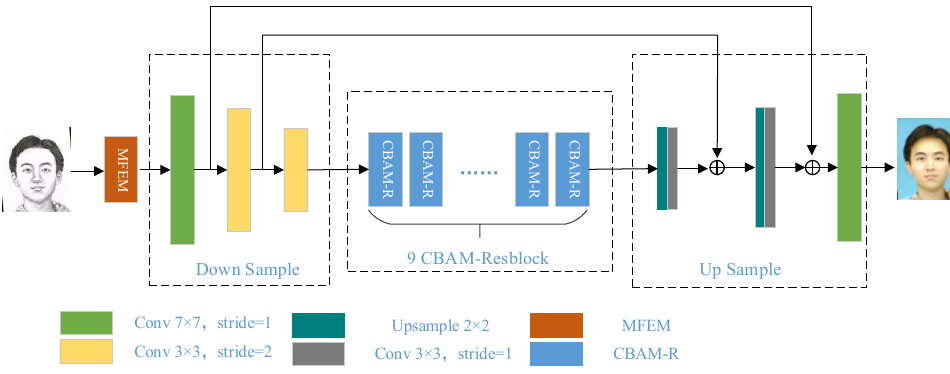
Figure 2. Generator network structure.